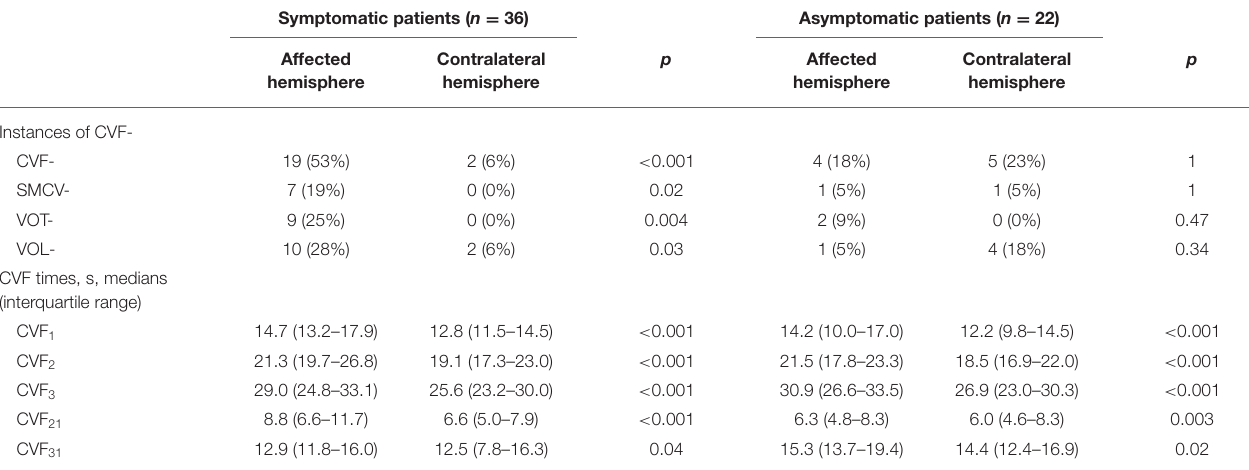
TABLE 2 | Instances of CVF- and CVF times of the affected and contralateral hemispheres.